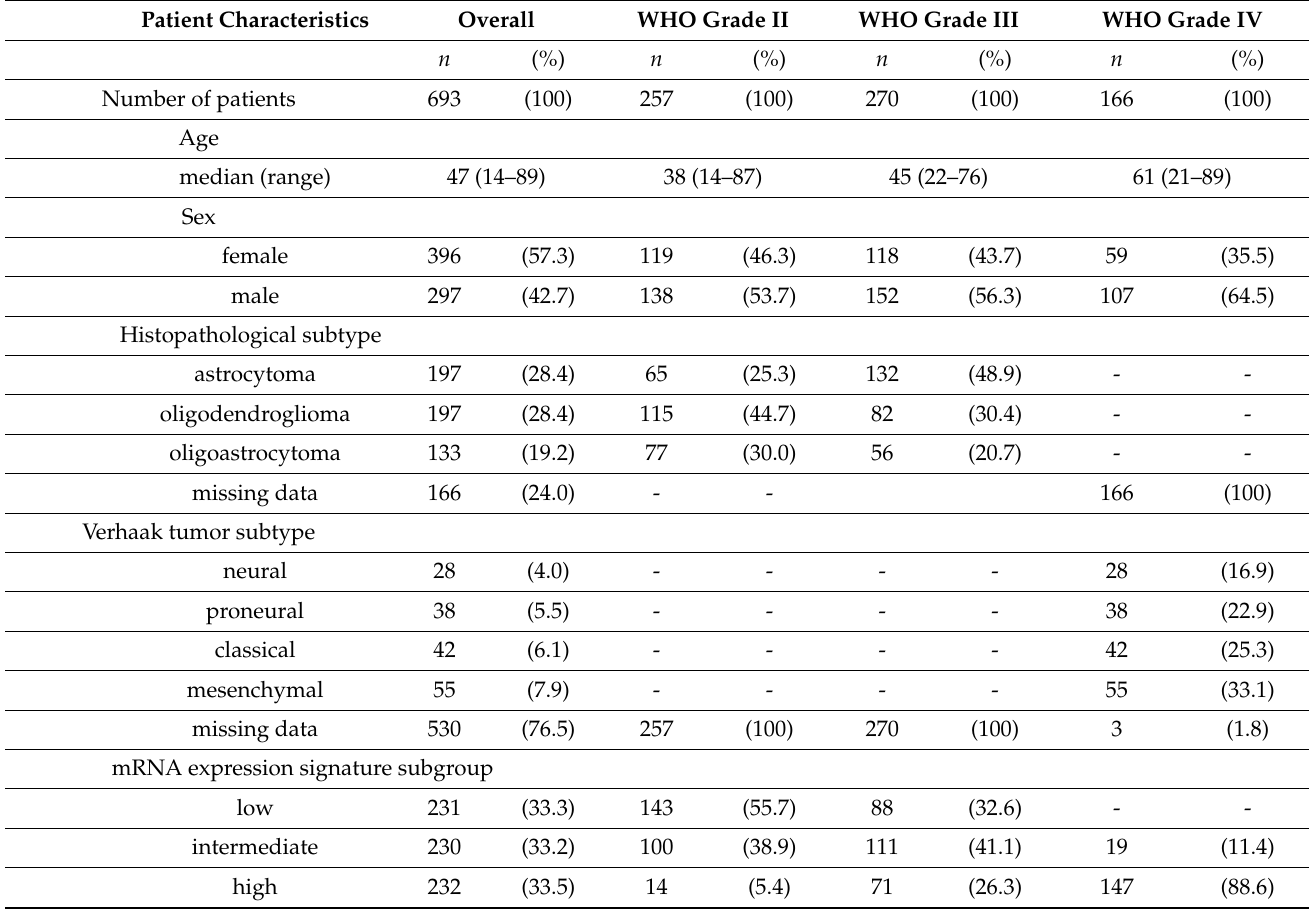
Table 1. Patient characteristics. Distribution of patient age, sex, histopathological, and Verhaak tumor subtypes and mRNA expression signature subgroups are shown for the entire cohort as well as distinct WHO glioma grades. Patient